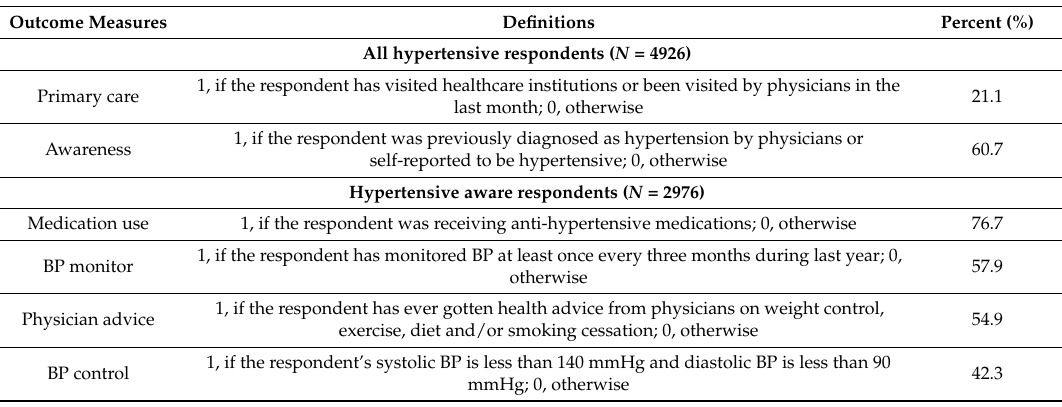
Table 1. Definition and description of hypertension